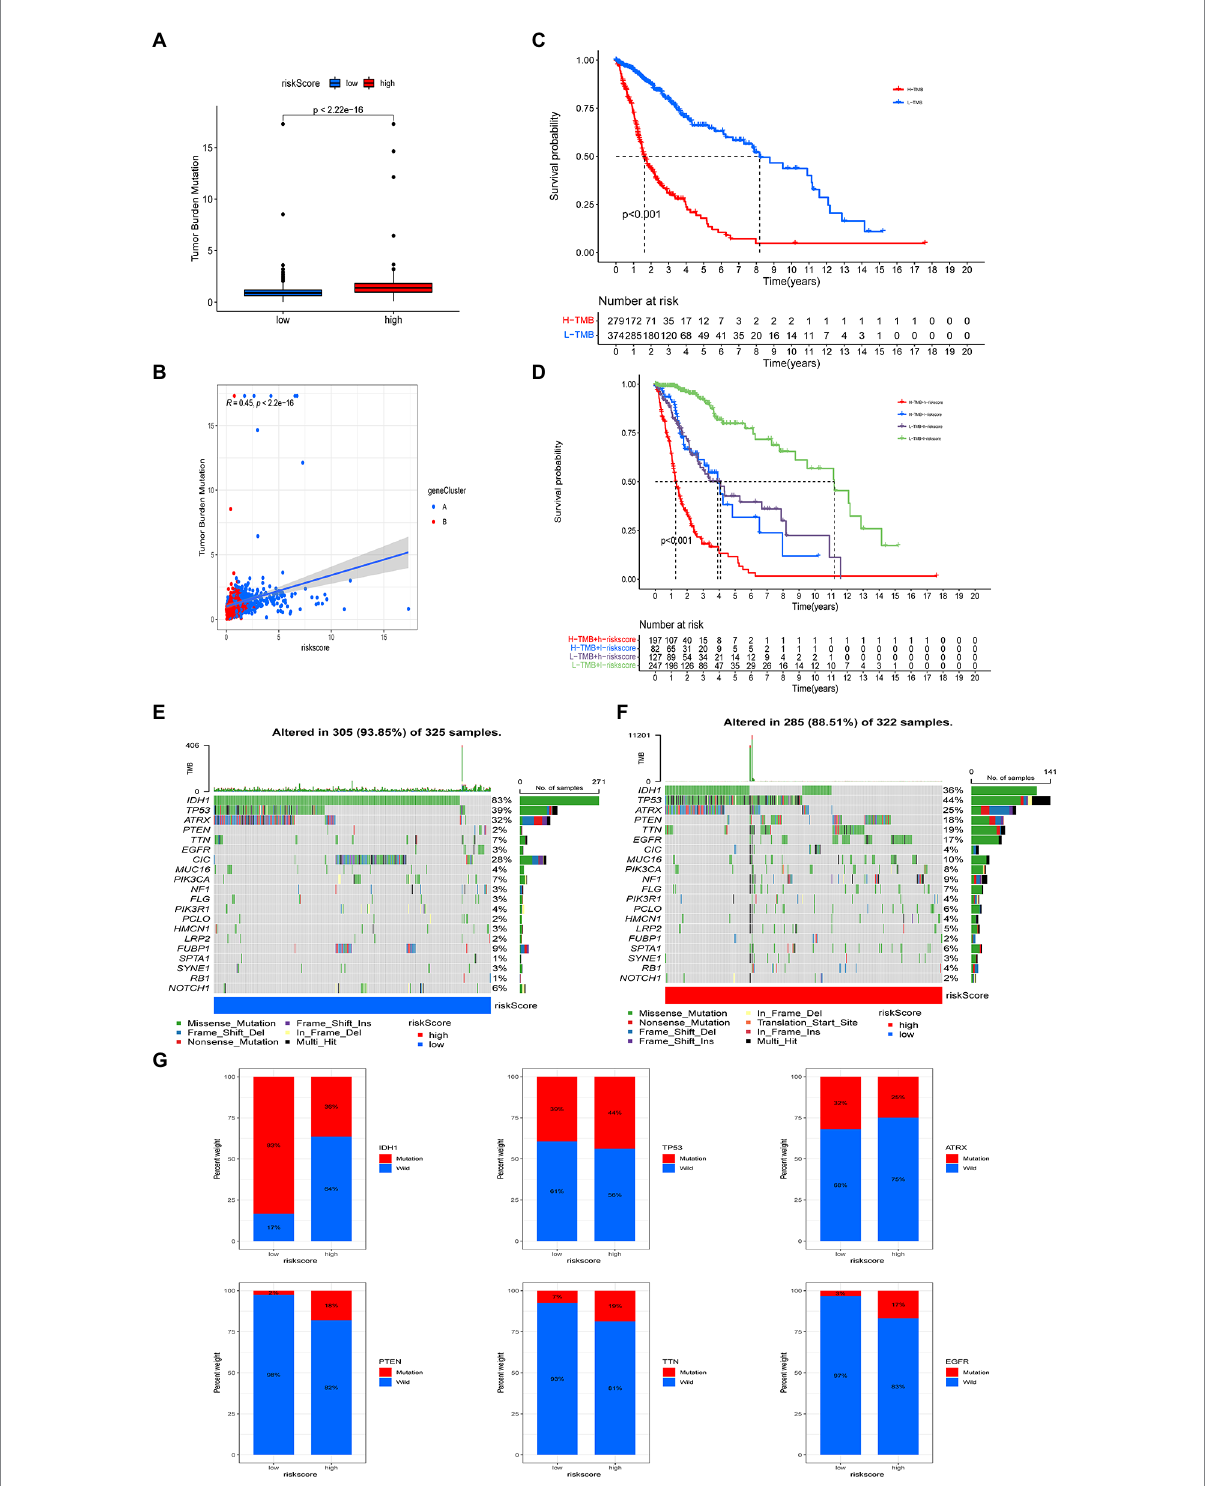
FIGURE 8 Comprehensive analysis of risk score in glioma. (A) Tumor mutational burden (TMB) in high and low risk score groups. (B) Kaplan–Meier analysis of overall survival (OS) between the high- and low-TMB groups. (C) Spearman’s correlation analysis of risk score and TMB. (D) Survival analysis among four groups stratified by risk score and TMB. (E,F) Waterfall plot of somatic mutation features associated with high and low risk scores. Each column represents one person. The upper bar plot shows TMB and the number on the right of the figure indicates mutation frequency for each gene. The right bar plot shows the proportion of each variant. (G) Comparisons of IDH , TP53 , EGFR , PTEN , TTN , and ATRX mutations between high and low risk score